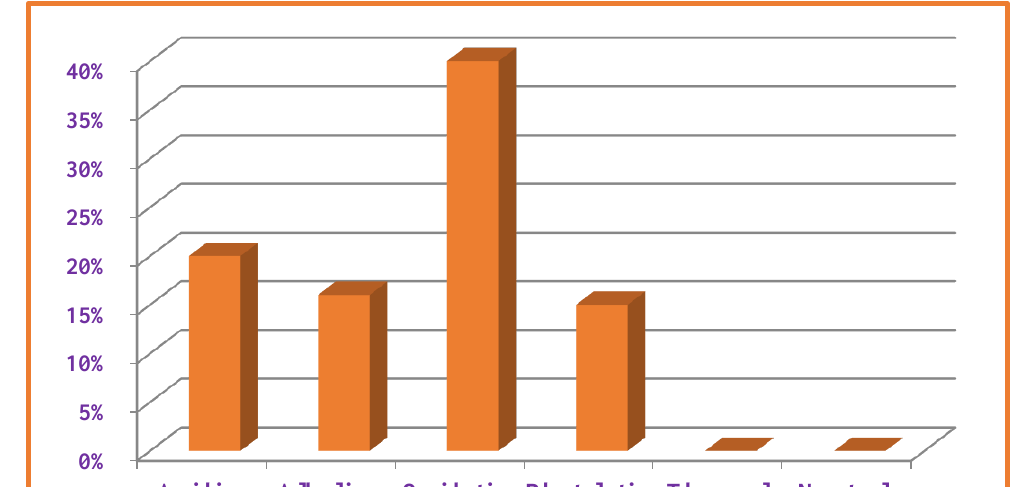
Figure 7. Degradation of VEL-CSD in different stressed conditions. Table 4. Assay of VEL and VEL-CSD after exposure to stressed studies.